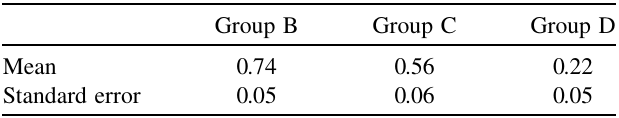
TABLE VIII. Average physics grades (normalized to 1) for self-diagnosis of the pre quiz 7